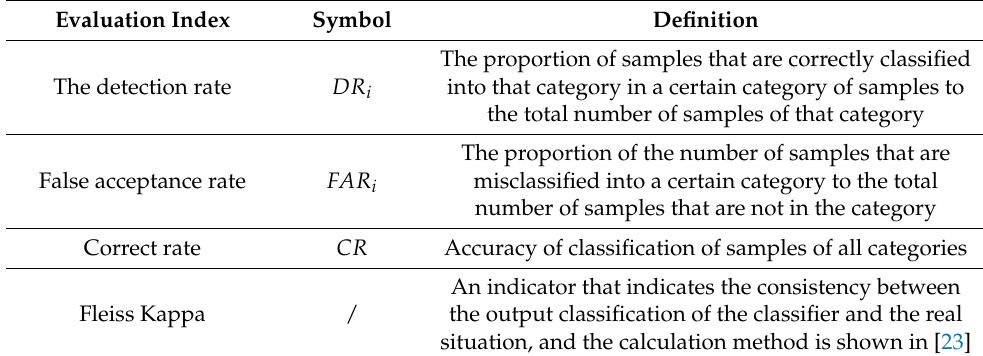
Table 3. Algorithm performance evaluation indicators.